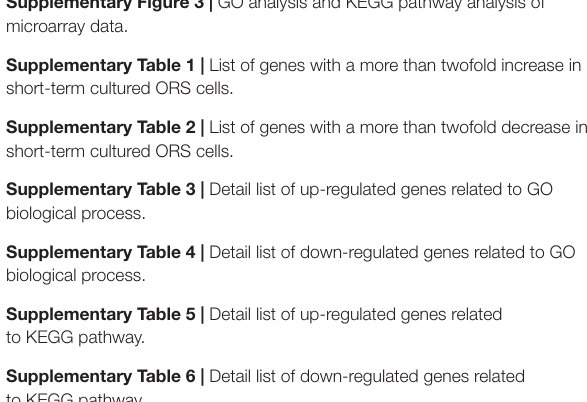
Supplementary Figure 1 | Hair follicles quantified in Figure 2 from the nude mice skin. Supplementary Figure 2 | High power images of boxed regions in Figure 2B . Supplementary Figure 3 | GO analysis and KEGG pathway analysis of microarray data.